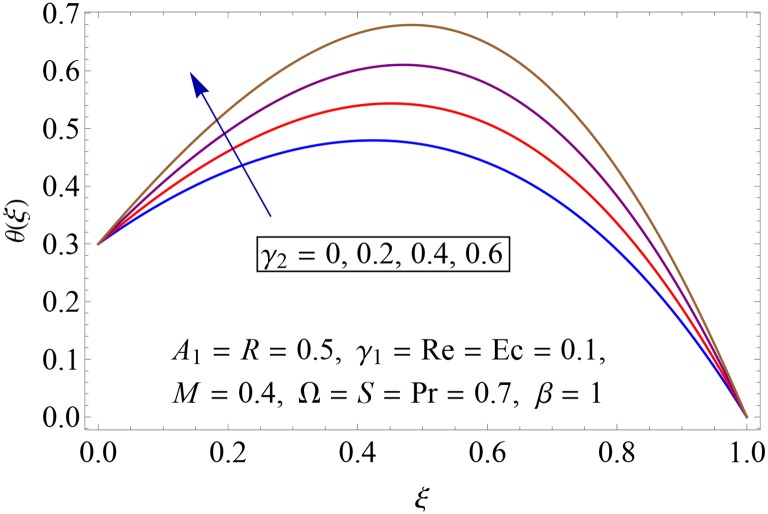
Impact of γ2 on θ(ξ).